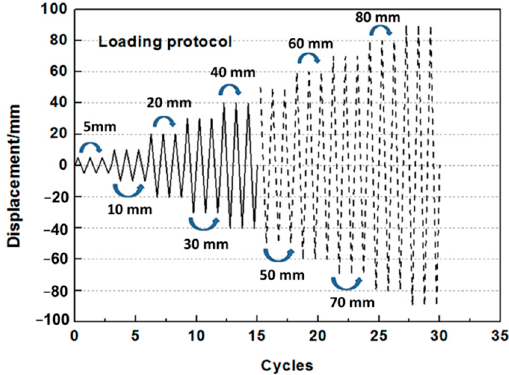
Figure 11. Schematic diagram of the loading protocol.